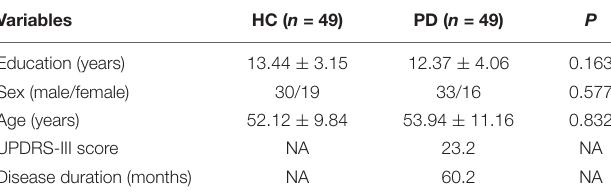
TABLE 1 | Baseline characteristics in Parkinson’s disease (PD) patients and healthy controls